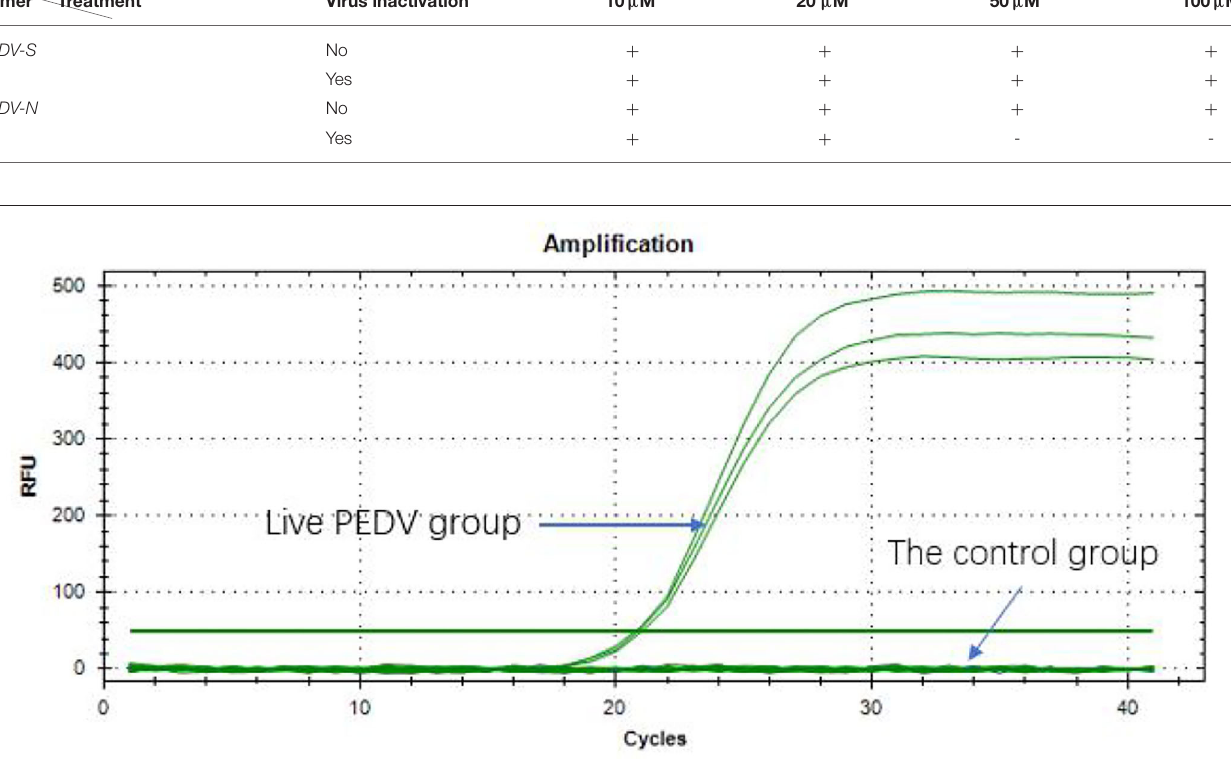
used in Figure 4B (y = − 3.0891x + 39.278, where x